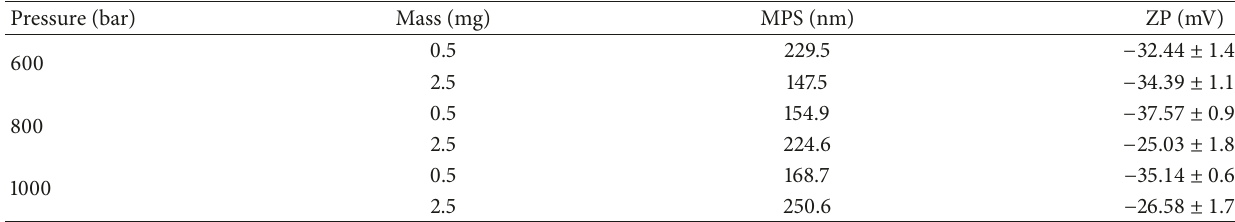
Table 7: Preparation of HCPTNPs with SDS by HPH.